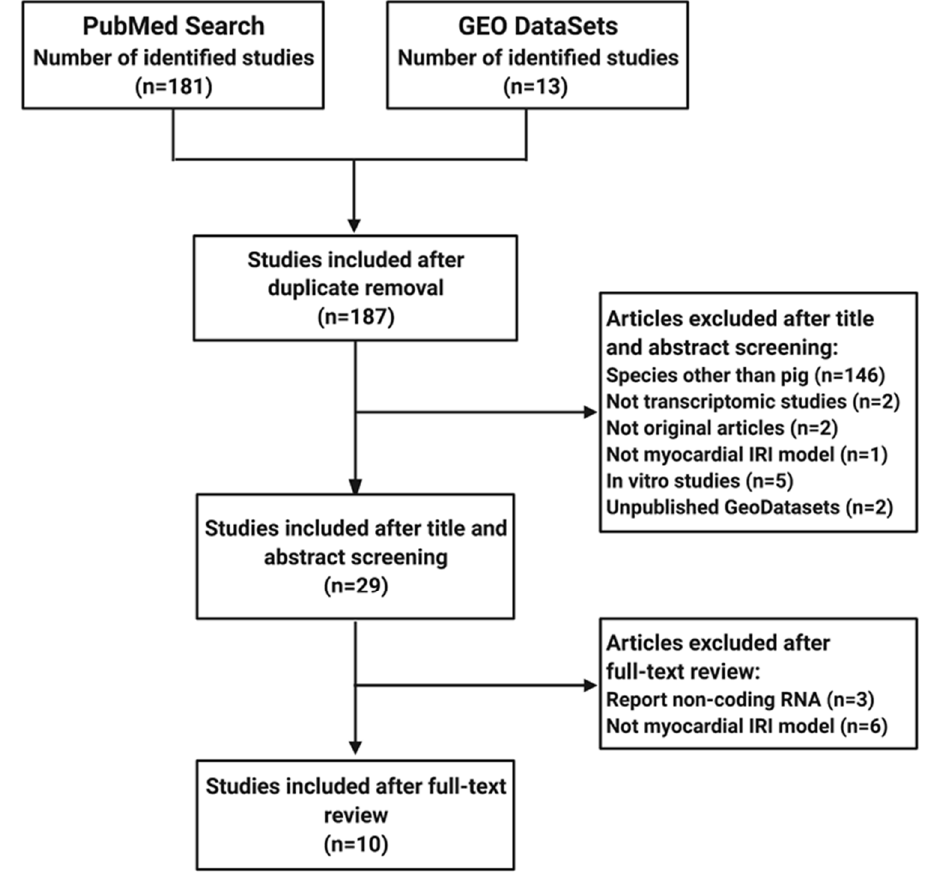
Figure 1. Diagram of the systematic review process.